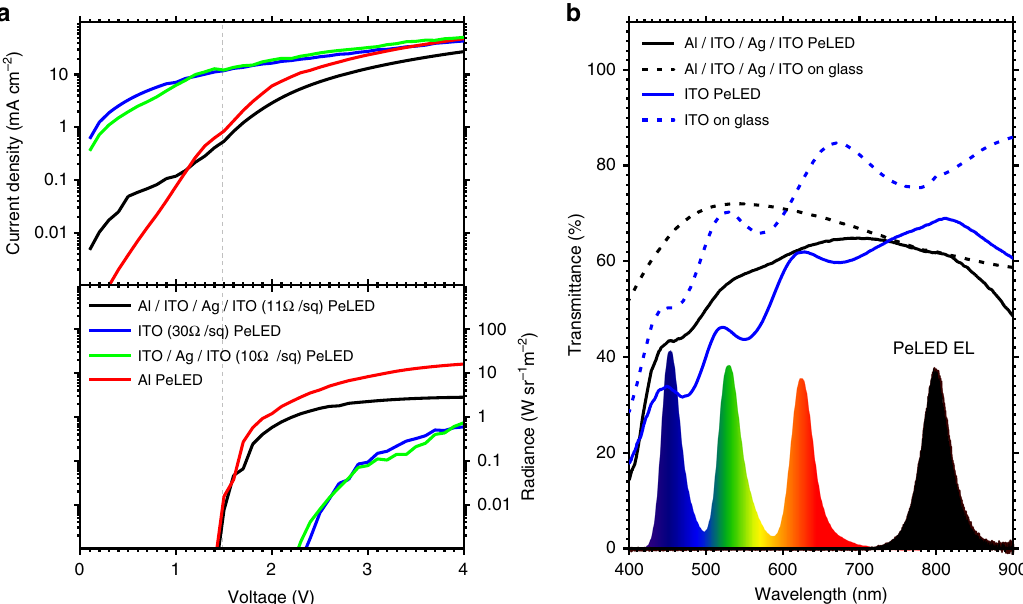
Fig. 2 Electrical and optical characteristics of transparent perovskite light-emitting diodes. a Comparison of current density (top graph) and radiance (bottom graph) between PeLEDs using Al/ITO/Ag/ITO (black line), ITO (blue line), ITO/Ag/ITO (green line), and Al (red line) as back electrodes. b Comparison of the optical transmittance of Al/ITO/Ag/ITO PeLED (black solid line) and ITO PeLED (blue solid line) and their respective Al/ITO/Ag/ ITO (black dashed line) and ITO (blue dashed line) transparent electrodes on glass. Bottom plots show the emission spectra of a typical smart-watch display, and the NIR EL spectrum of the